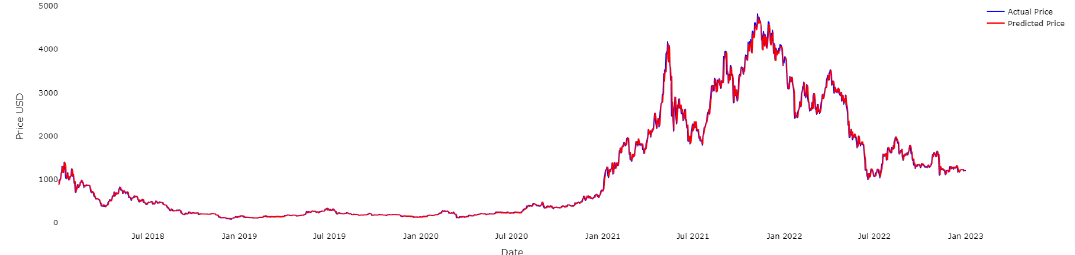
Figure 14. ETH—actual and predicted results using the Bi-LSTM model.